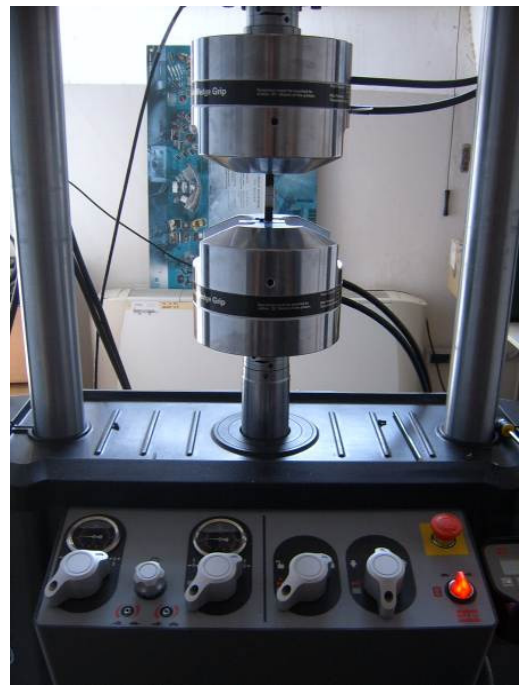
Figure 6. Setup of tensile test.